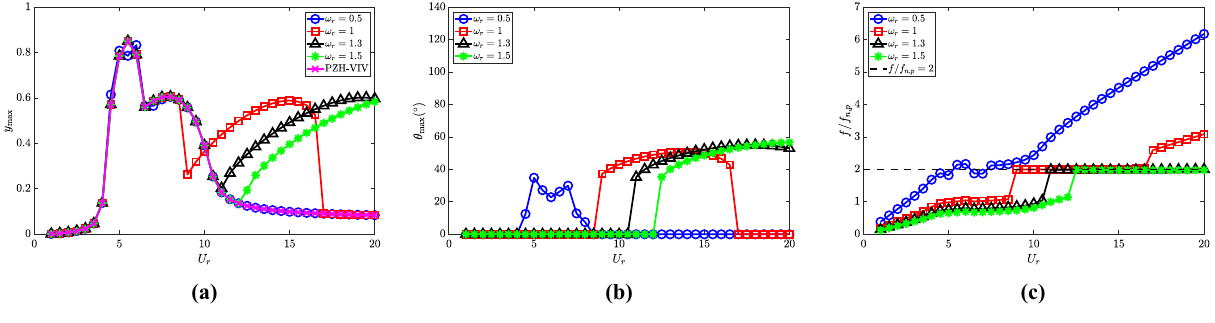
Figure 5. Response characteristics of the system for various ω r with U r : ( a ) maximum non-dimensional oscillation amplitude ( y max ) of the cylinder, ( b ) maximum angular rotation of the pendulum θ max in degrees ( ◦ ) and ( c ) dominant frequency with respect to pendulum natural frequency f / f n , p . Here, m = 0.3 , l d = 0.1 and ζ θ = 0.0011 .